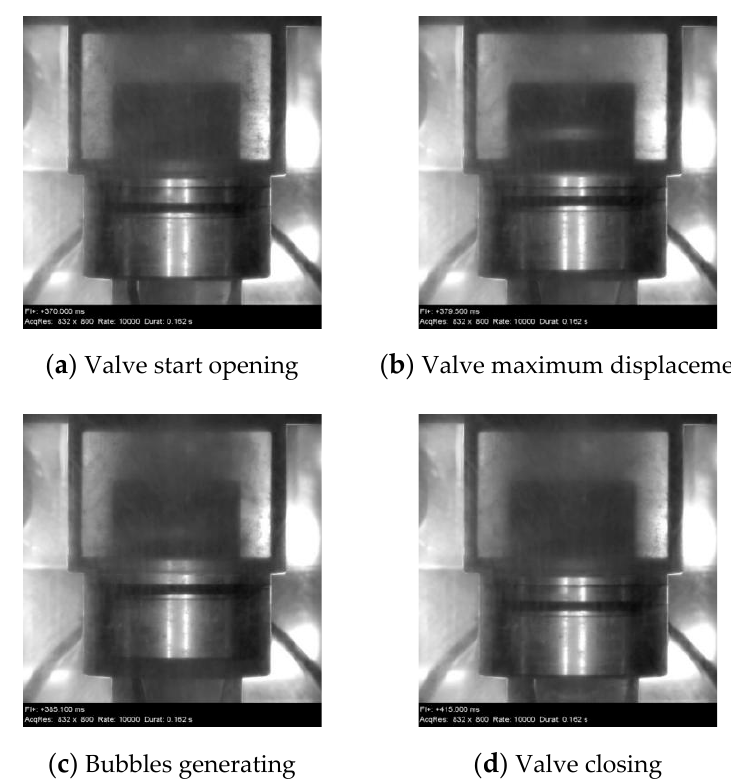
Figure 10. Sequence of images for valve opening in the plexiglass liquid end of the reciprocating plunger pump.